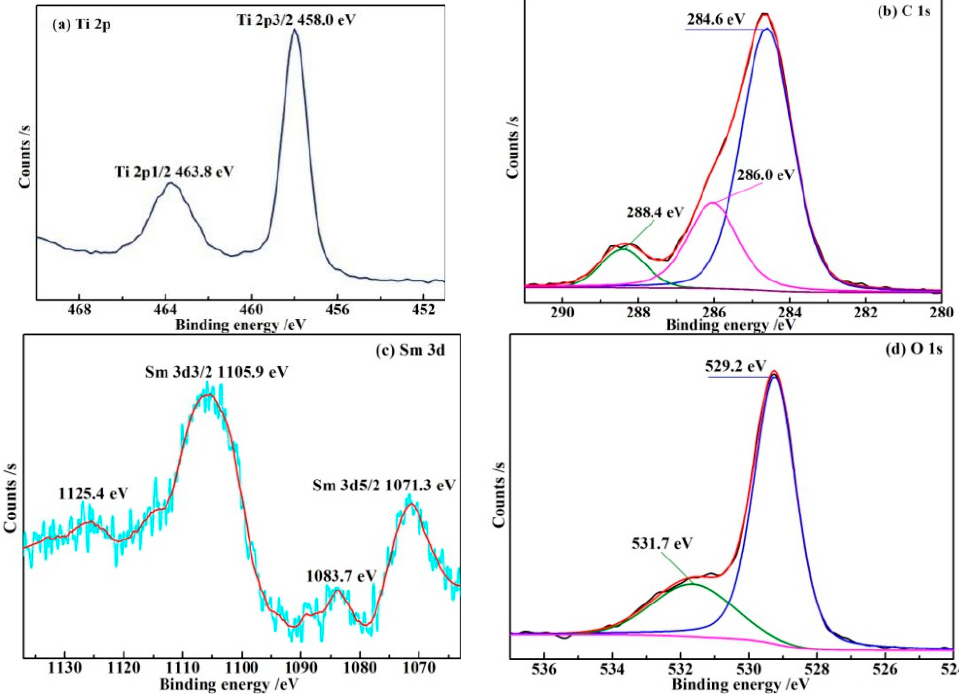
Figure 4. XPS spectra for the Sm-C-TiO 2 . ( a ) Ti 2p; ( b ) C 1s; ( c ) Sm 3d; ( d ) O 1s.